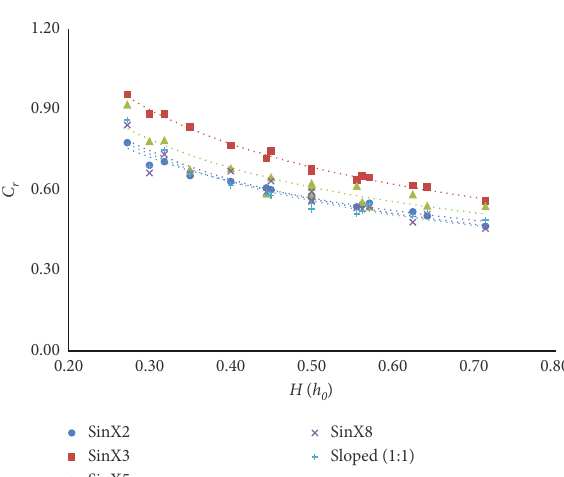
Figure 13: Model results of reflected wave height for sinusoidal and sloped walls.